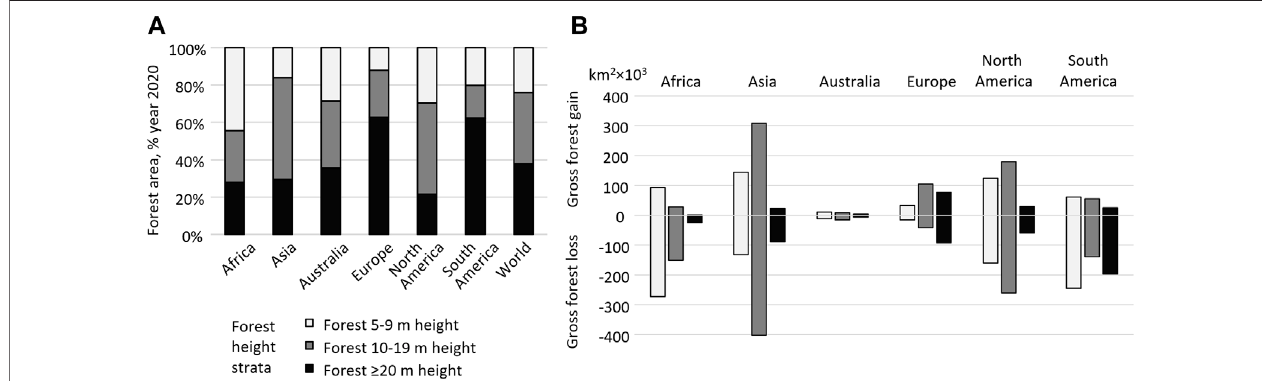
FIGURE 3 | (A) Percent of each forest height strata within the year 2020 forest area. (B) Gross forest area loss and gain 2000 – 2020 by forest height strata.